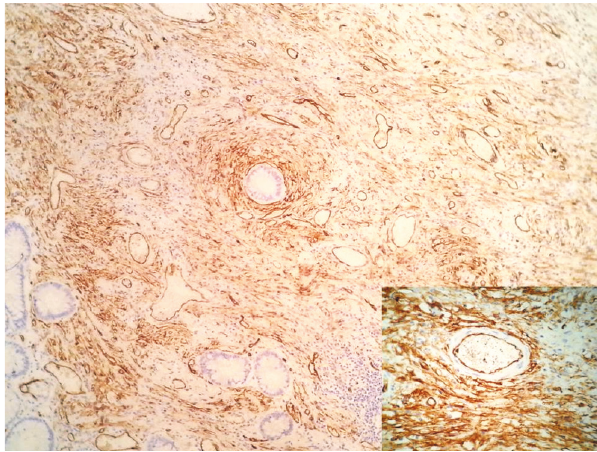
Figure 5: CD34 immunostaining showing diffuse positivity in the spindle